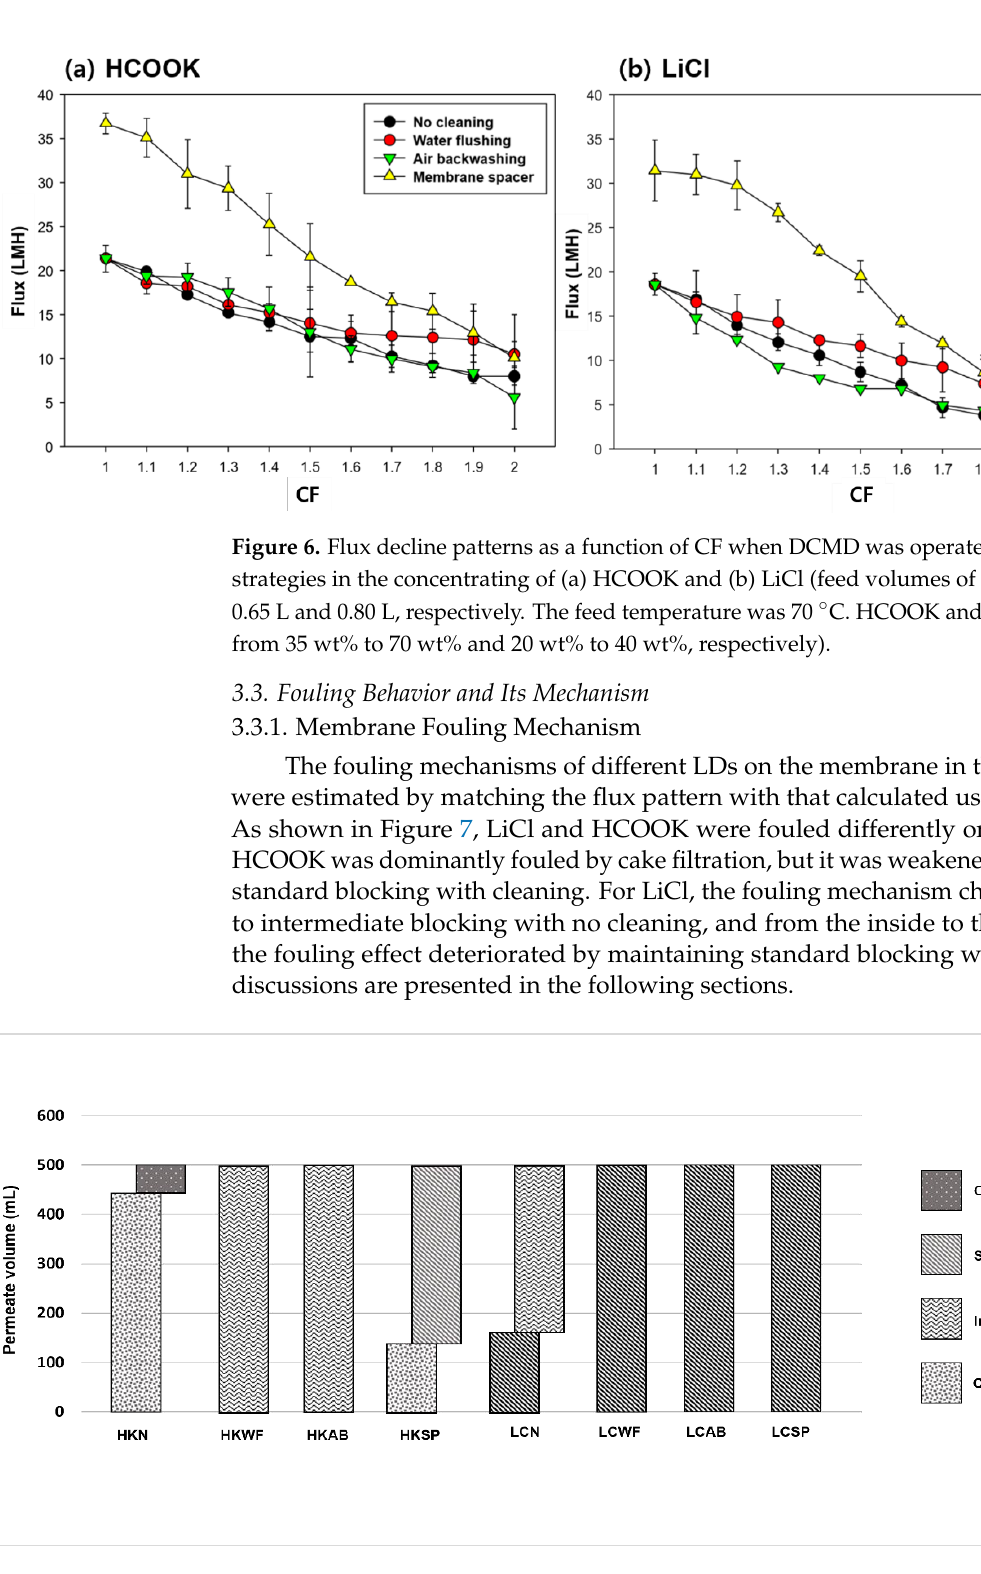
Figure 7. The fouling mechanism data in terms of permeate volume with no cleaning and physical cleaning methods. LDs were expressed as HCOOK to HK and LiCl to LC. LDs with cleaning methods were abbreviated to HKN for HK with no cleaning; HKWF for HK with WF, HKAB for HK with AB, and HKSP for HK with SP. Similarly, LCN for LC with no cleaning, LCWF for LC with WF, LCAB for LC with AB, and LCSP for LC with SP.